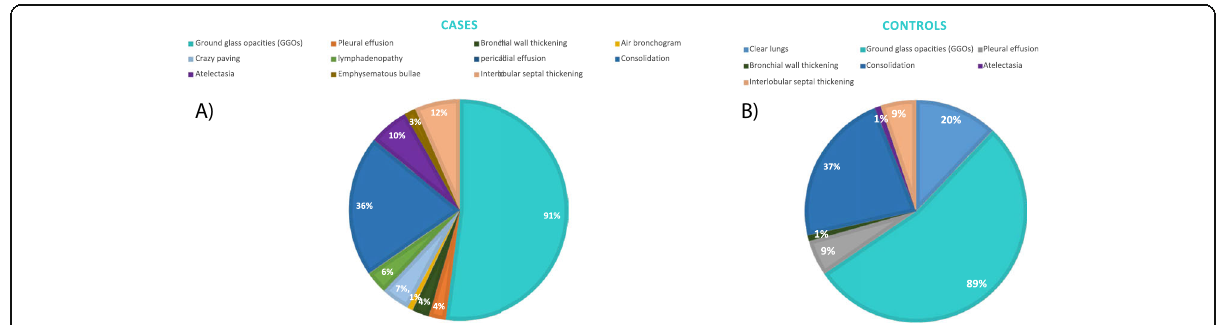
Fig. 2 Radiological findings among the studied patients. a Patients treated with stem cell nebulization. b Control